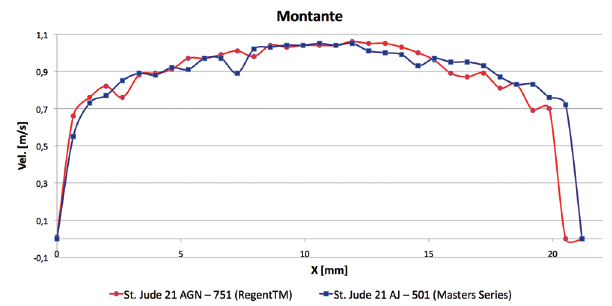
Fig. 5 - Velocity profiles at 30 mm upstream of the